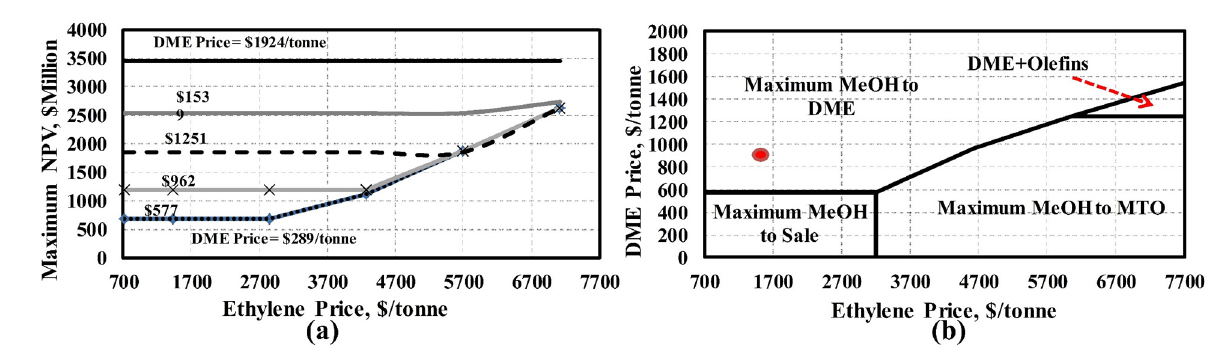
Figure 5. Effect of olefins and DME prices on ( a ) the maximum NPV of process, ( b ) optimal product portfolio (Fayetteville shale gas). The base case prices are marked with a red